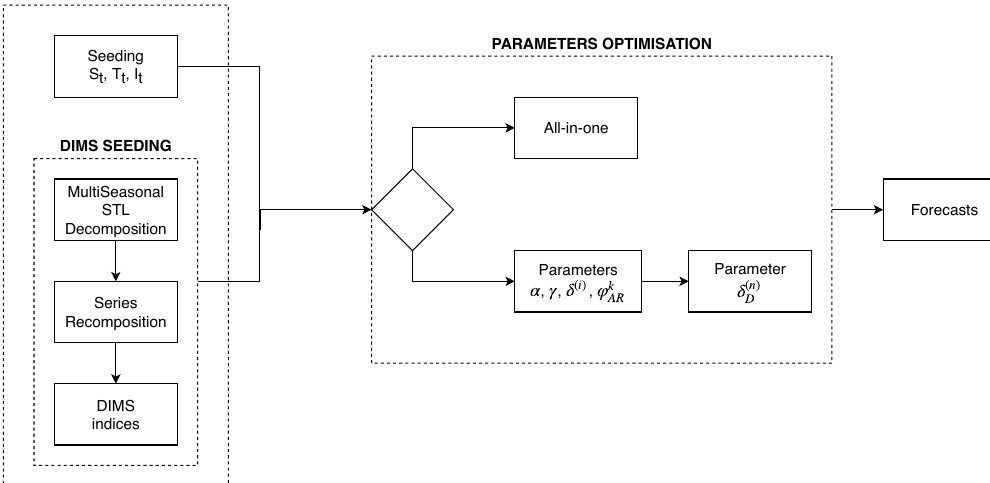
Figure 2. Flow chart for the utilisation of the discrete-interval moving seasonality (DIMS). Initialisation is found at the left side of the figure. The right side explains the parameter optimisation and